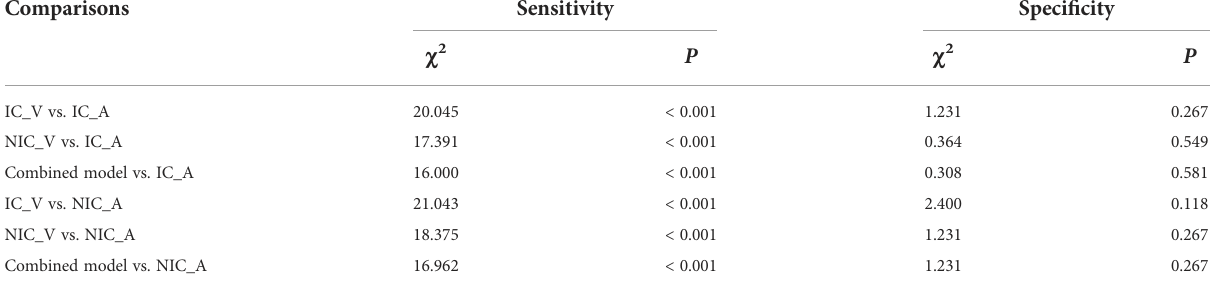
TABLE 4 Comparisons of sensitivity and speci fi city. Comparisons